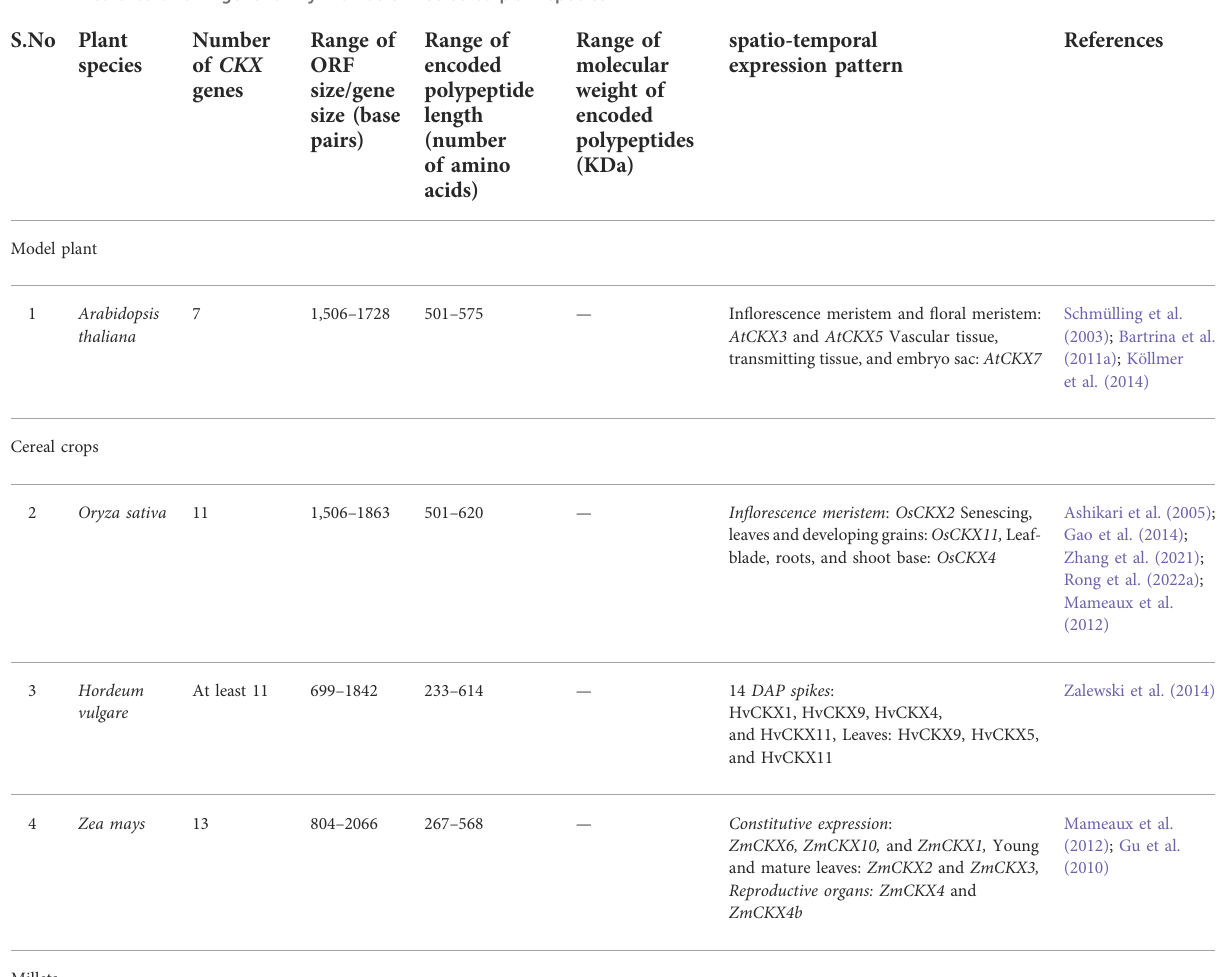
TABLE 1 Features of CKX gene family members in selected plant